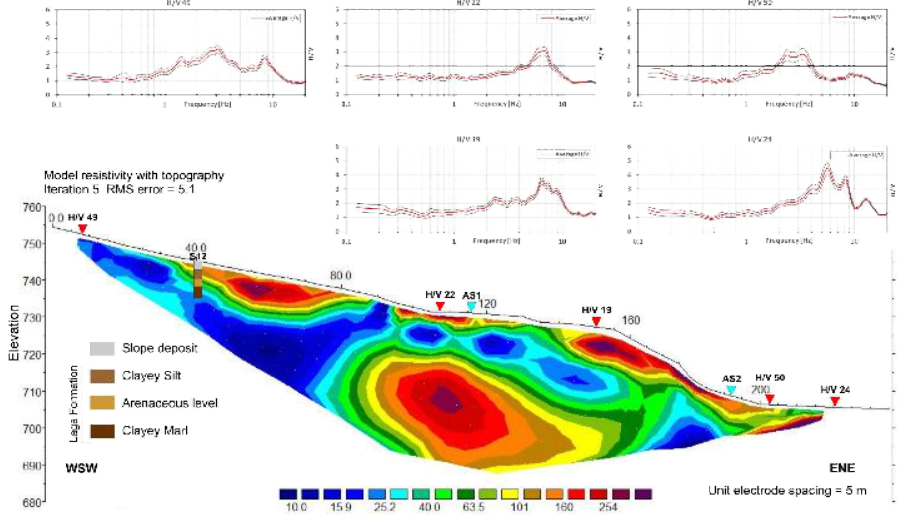
Figure 8: Electrical image (ERT 01) with HVNSR functions (on the top) carried out at Pescara del